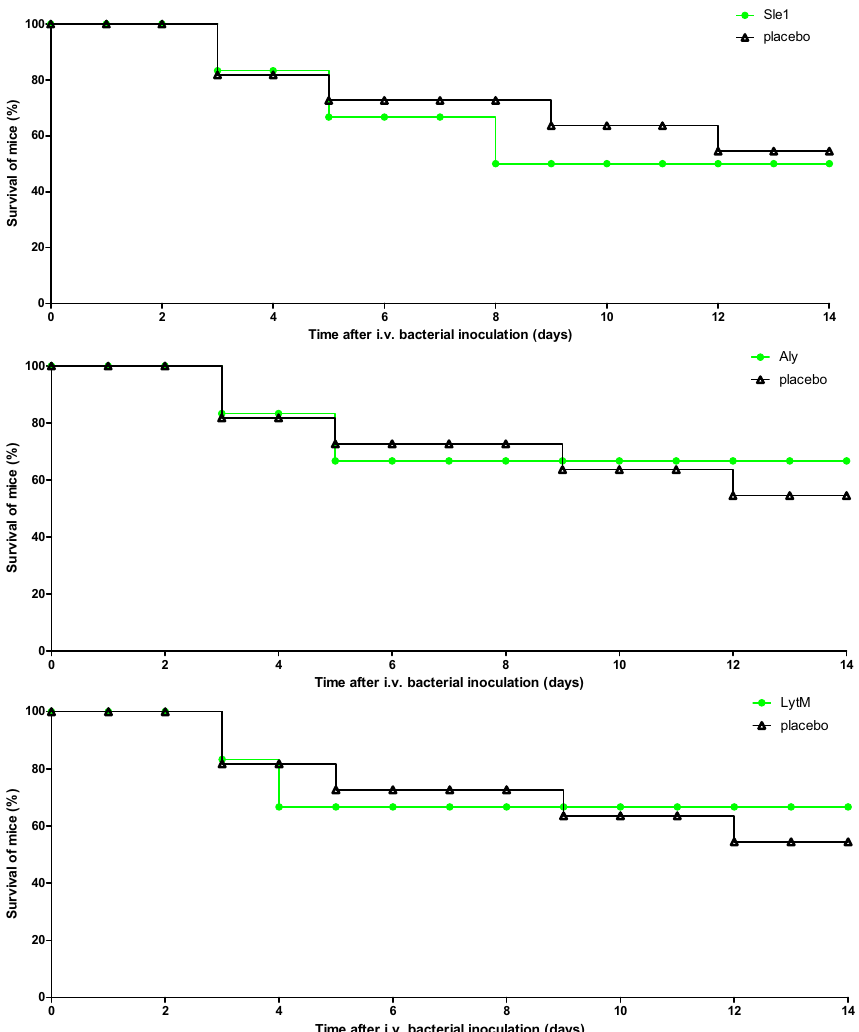
Figure 5. Survival rates of immunized mice challenged with S. aureus . Mice immunized with Sle1, Aly or LytM (n = 6 immunized mice per antigen, n = 11 placebo-immunized mice) were subjected to intravenous inoculation of S. aureus isolate P (3 × 10 5 CFU). Subsequently, the mice were observed for 14 days. Green symbols, Sle1-, Aly- or LytM-immunized mice; black symbols, placebo group. A significant difference was not observed in animal survival rate (P > 0.5, log rank